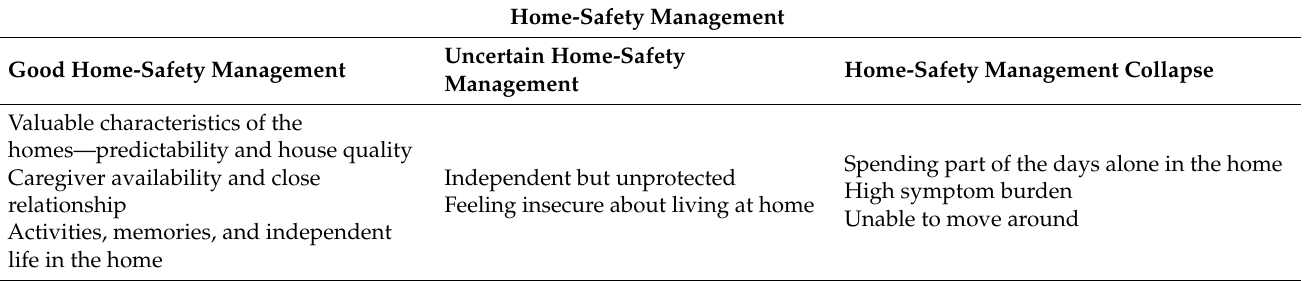
Table 2. The overarching theme ‘home-safe management’ with themes and